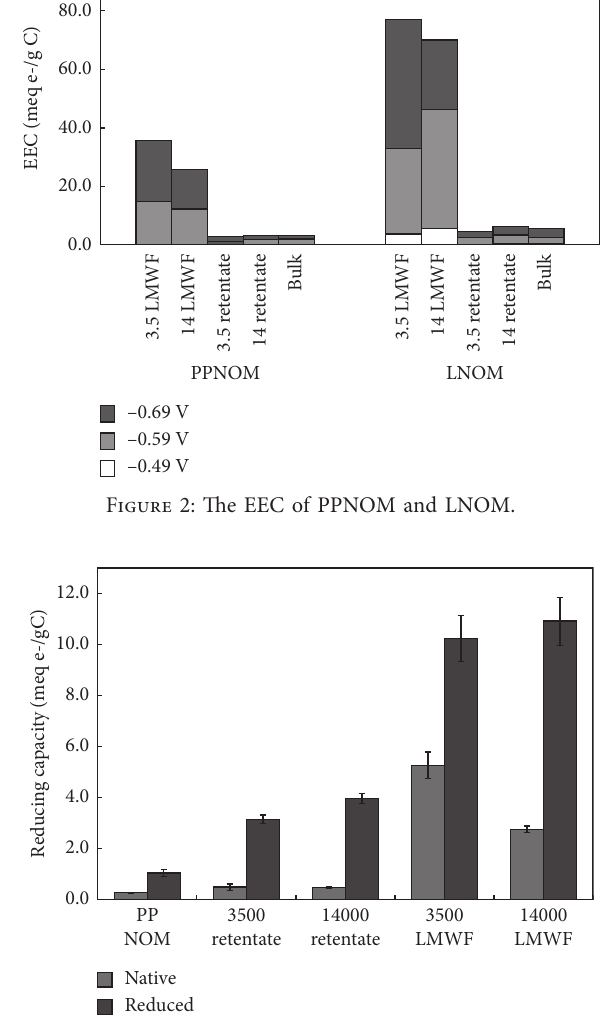
Figure 3: The reducing capacity of different molecular weight fractions of PPNOM in their native and reduced states. Each re- duced sample was prepared by H 2 in the presence of two Pd catalysts. The reducing capacities were determined by the difference of Fe[III] before and after reacting with ferricyanide. Each data were normalized into meq e − /g C, which is equal to mmol e − /g C in numerical